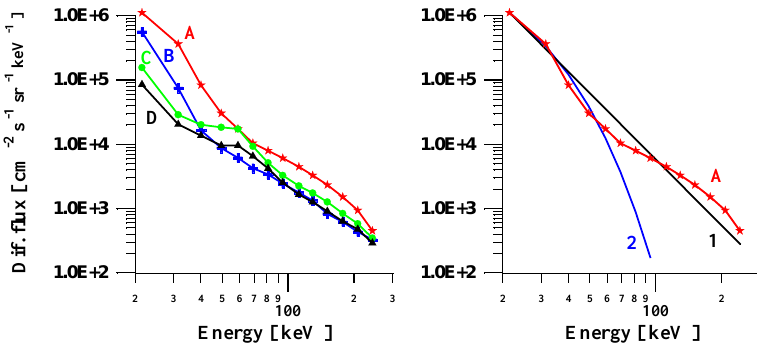
Fig. 2. On the left panel the dependence of differential fluxes on energy is shown in double logarithmic scale. Spectra of the omnidirectional differential fluxes observed by CRRES averaged over four time intervals, 02:33–02:47, 03:20–03:50, 04:15–04:45, and 04:00–04:15 UT, are denoted by A , B , C , and D , respectively. On the right panel the first spectrum ( A) is fitted by the power-law and Maxwellian functions, denoted by 1 and 2, respectively. The almost linear dependence suggests that the spectrum is defined by a power law, and is not